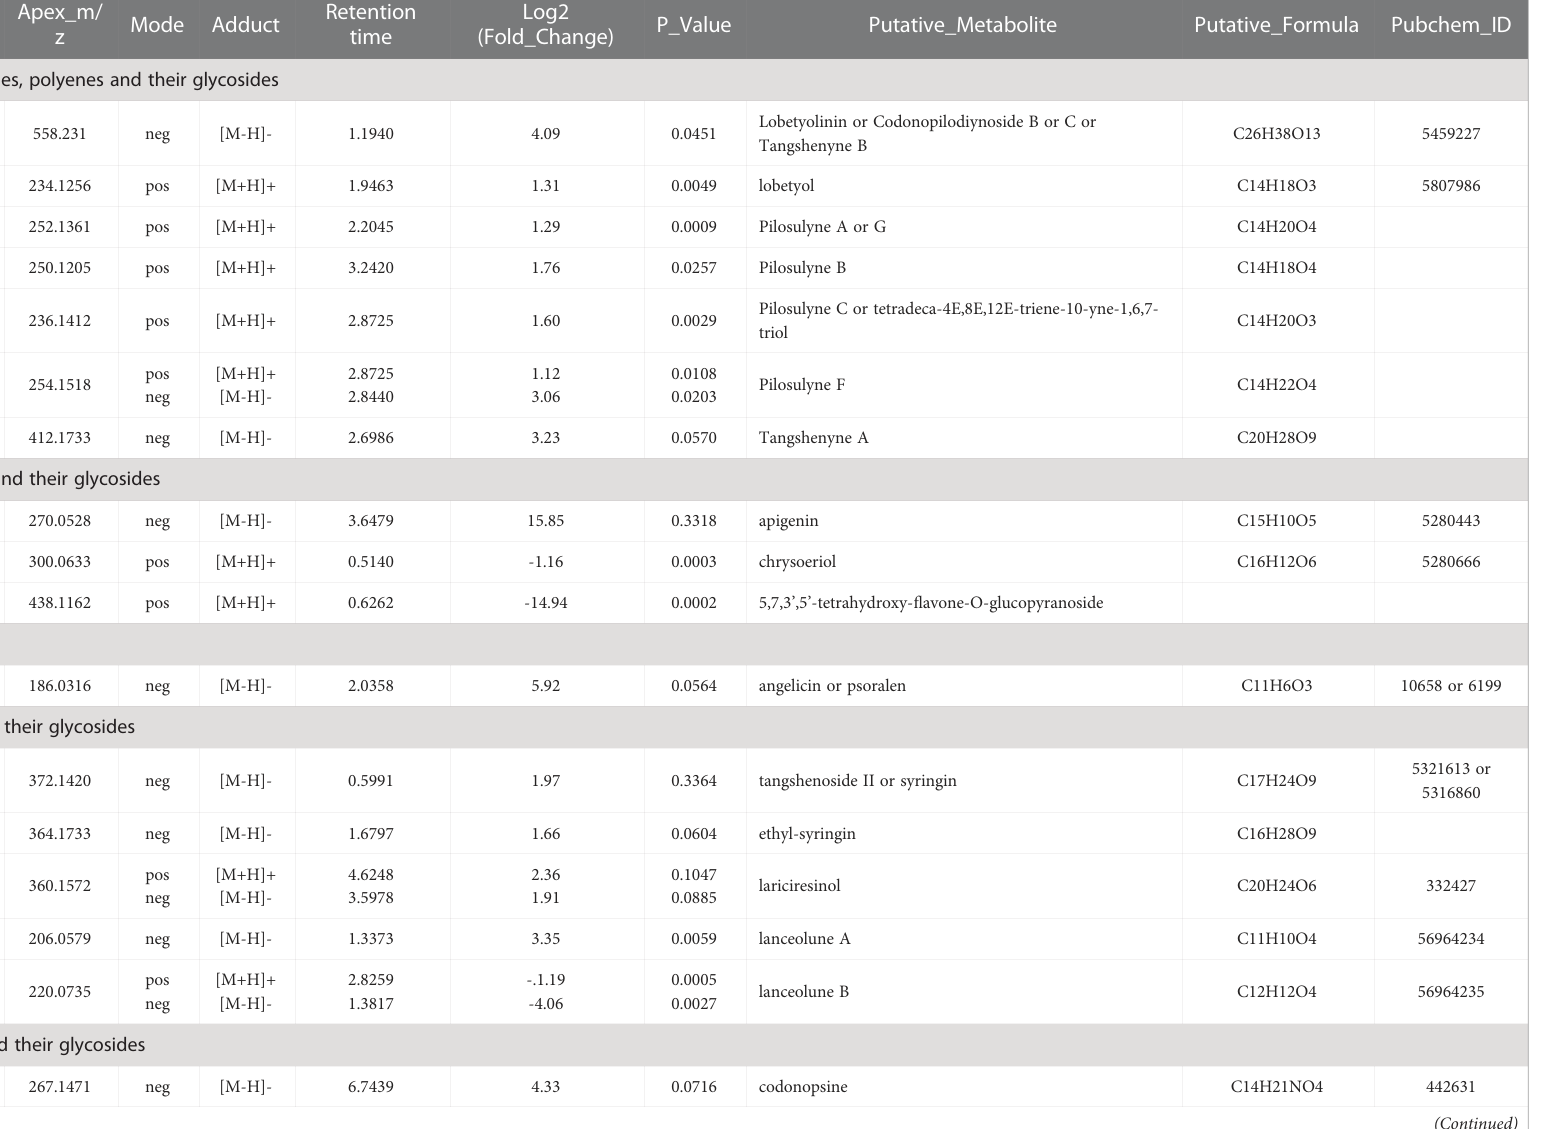
Polyacetylenes, polyenes and their